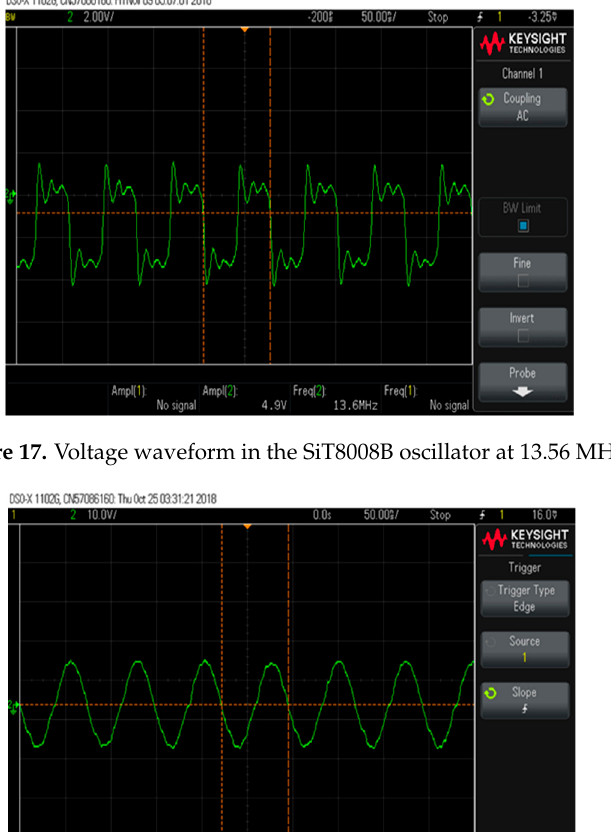
). (cid:3273) ). ). X (cid:3273)